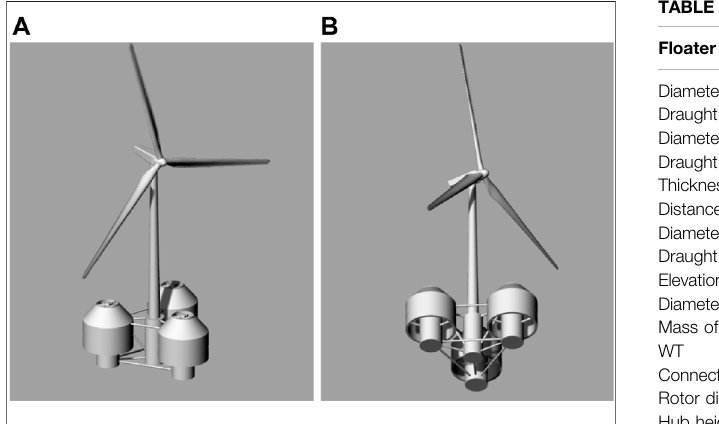
FIGURE 1 | 3-D representation of the multi-purpose fl oating structure suitable for offshore wind and wave energy exploitation: (A) above (left), (B) below (right) sea water level (SWL) (Konispoliatis et al., 2021)